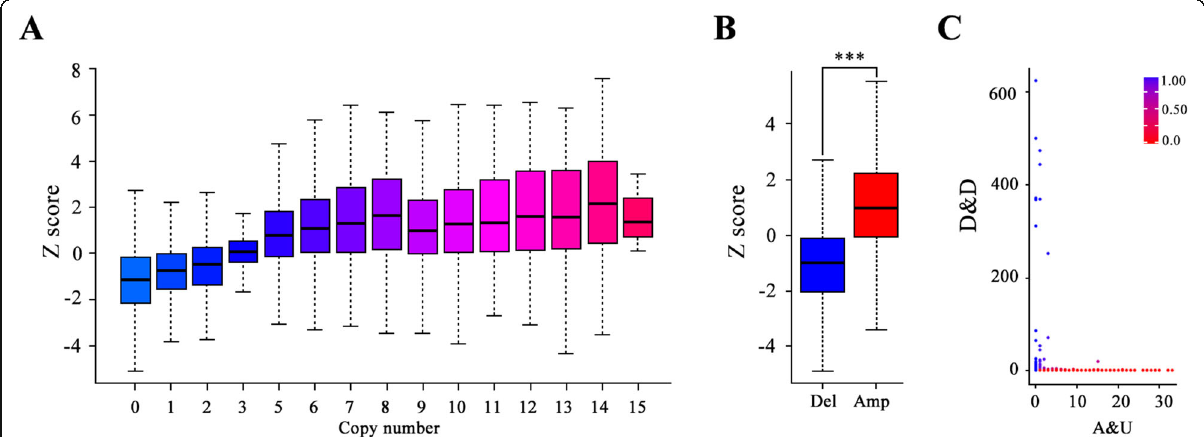
Fig. 6 Validation studies of correlation between CNV and differential gene expression on CCLP. a . Boxplots show the relationship of Z score (y- axis) versus copy number value (x-axis, processed by PICNIC) among 1020 cell lines. b. The significant difference between Z scores of copy number amplified genes versus copy number deleted genes. c. Scatter plot shows the distribution of genes based on the frequency of copy number amplification and expression level upregulation (x-axis) and the frequency of copy number deletion and expression level downregulation (y-axis). The color represents the count ratio of copy number deletion and expression level downregulation against copy number amplification and expression level upregulation, blue representing higher ratio of copy number deletion and expression level downregulation, red representing higher ratio of copy number amplification and expression level upregulation. A&U: copy number amplification and expression level upregulation. D&D: copy number deletion and expression level